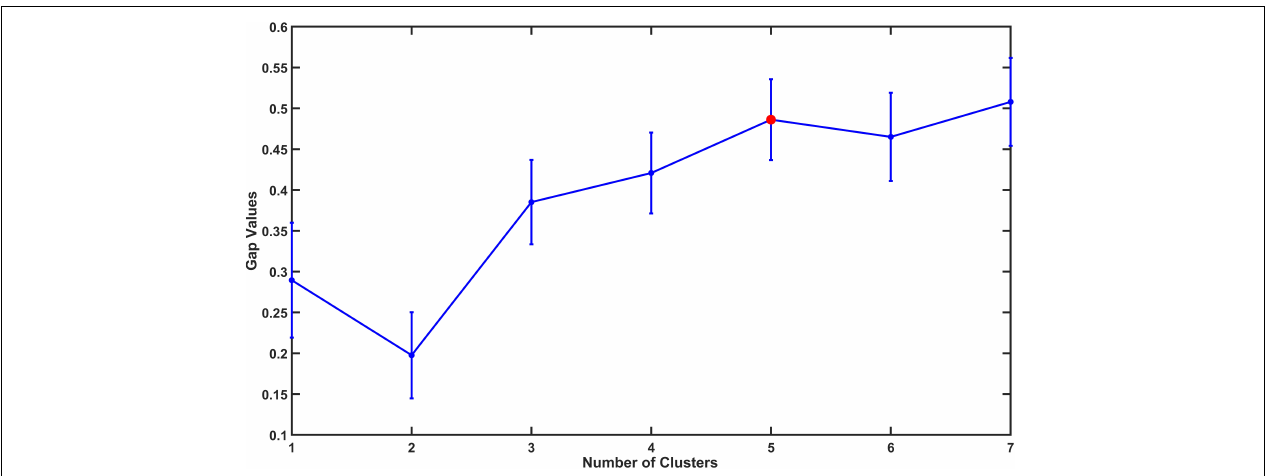
FIGURE 3 | Gap statistics for determining optimal value of clusters. Red dot represents the optimal clusters for k-means analysis.